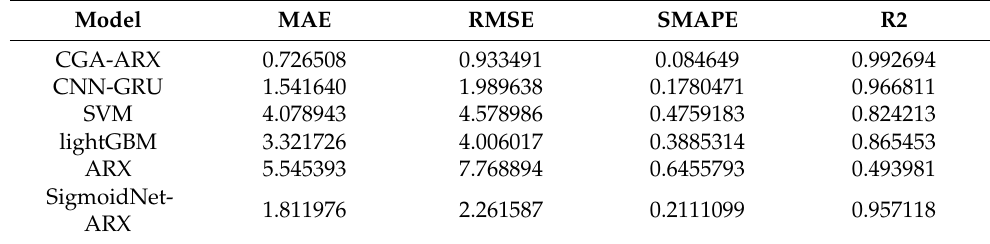
Table 4. Evaluation indexes of the different models.